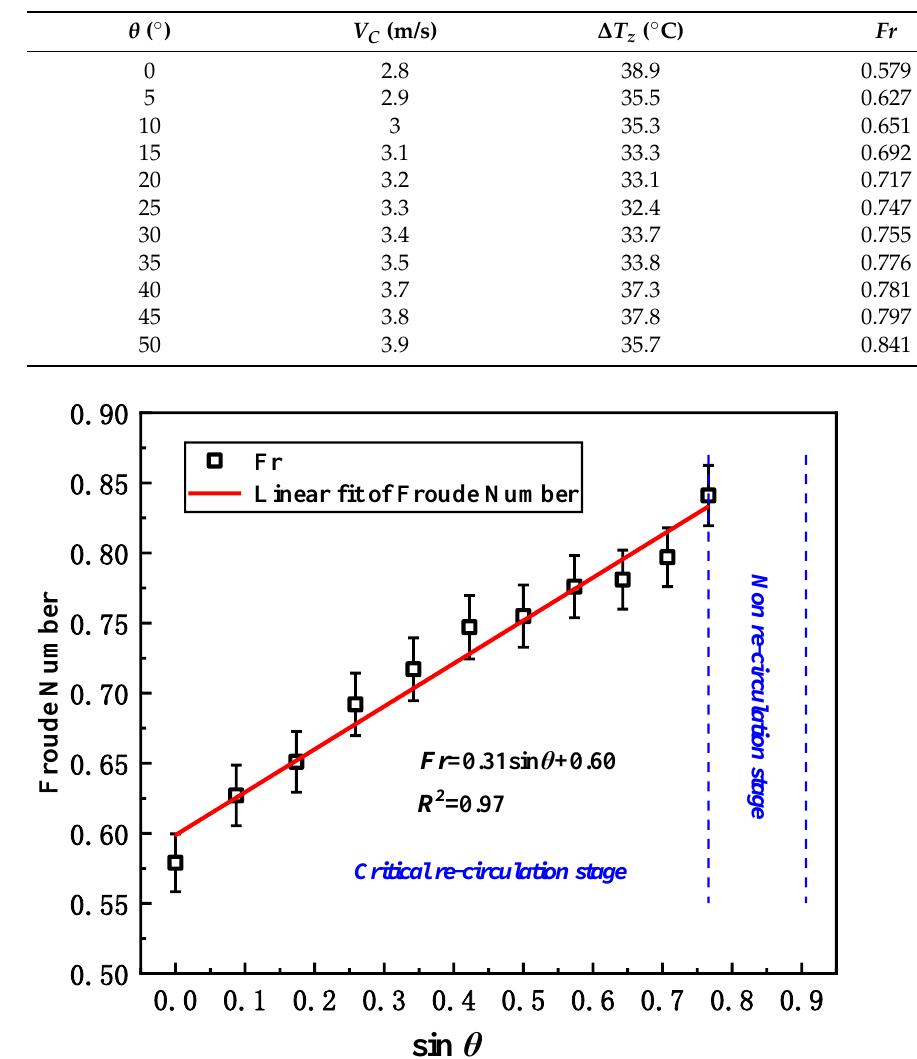
Figure 7. The critical Froude number in relation to various angles of θ .